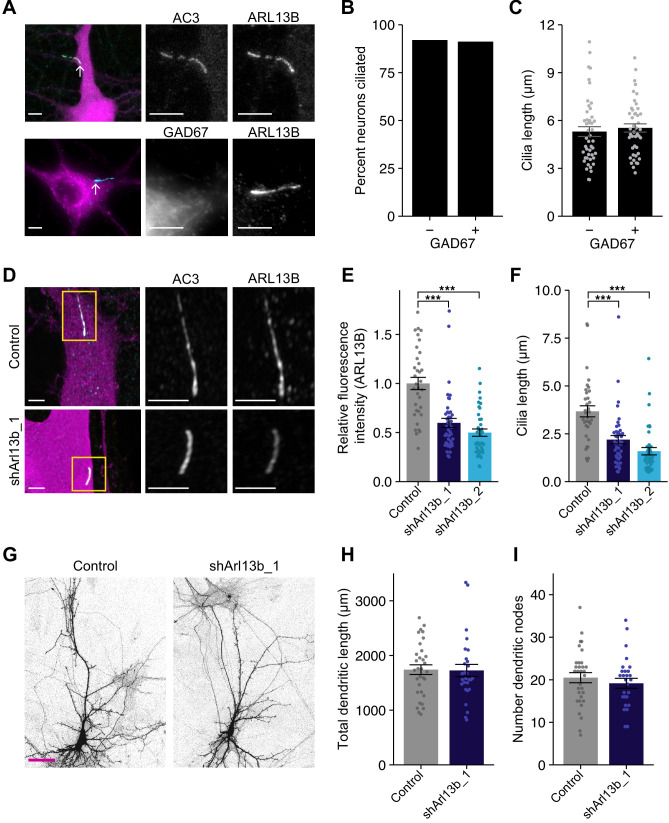
Acute knockdown of ciliary proteins does not alter dendritic morphology of cortical pyramidal neurons.(A) Representative images of a DIV11 pyramidal neuron expressing GFP (top), and an inhibitory neuron immunolabeled with GAD67 antibodies (bottom). Cilia (arrows) are immunolabeled using antibodies against AC3 and ARL13B (top) or ARL13B alone (bottom). Scale bars: 5 μm. (B) Percentage of inhibitory (GAD67+) and excitatory (GAD67−) neurons containing cilia immunolabeled with antibodies against AC3 and/or ARL13B. n = 150 total; three dissociations. (C) Lengths of cilia in excitatory and inhibitory neurons. Each dot is a measurement from a single neuron. Bars are average ± SEM. n: GAD67+ = 44, GAD67− = 46; five dissociations. (D) Representative images of neurons expressing GFP alone (top) or shArl13b_1 and GFP (see Key Resources) (bottom). Cilia were immunolabeled with antibodies against AC3 and ARL13B. Images at right show enlarged (2.5×) views of cilia (yellow boxes). Scale bars: 5 μm. (E and F) Relative fluorescence intensities of immunolabeled ciliary ARL13B (E) and cilia lengths (F) in neurons transfected with the indicated plasmids. Each dot is a measurement from a single neuron. Values in (E) are normalized to intensity in control neurons. Bars are average ± SEM. *** indicates p<0.001 for the indicated conditions (Kruskal–Wallis with Dunn’s multiple comparisons test). n: Control = 34, shArl13b_1 = 43, shArl13b_2 = 40; four dissociations. (G) Representative images of pyramidal neurons expressing GFP alone (control) or shArl13b_1 and GFP. Scale bar: 50 μm. (H and I) Total lengths (H) and number of branch points (I) of apical-like dendritic arbors of neurons expressing GFP or shArl13b_1 and GFP. Each dot is a measurement from a single neuron. Bars are average ± SEM. n: Control = 32, shArl13b_1 = 28; four dissociations. Here and below, statistical tests used and exact p-values for each comparison are shown in Supplementary file 1. Also see Figure 1—figure supplement 1.
Figure 1—source data 1.Source data for Figure 1.